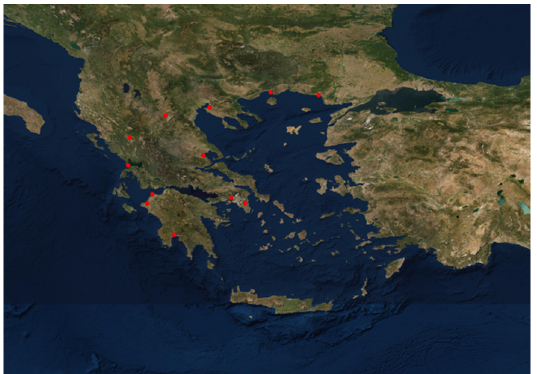
Figure 3. Locations of stations used for verification purposes.